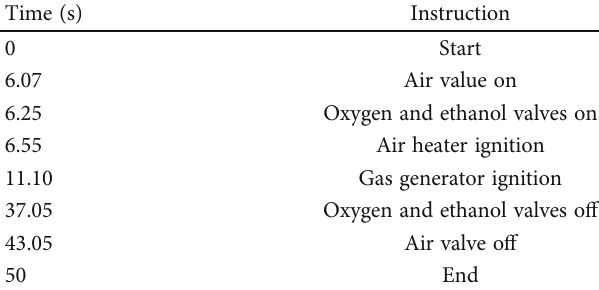
Figure 2: Schematic of the experimental apparatus. Table 1: Startup